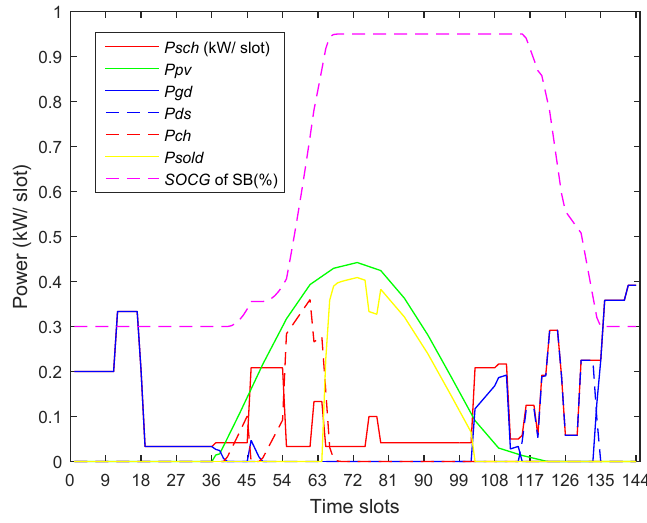
Figure 22. Load profile for maximal reduction in CE using 2S-ToUP (DS) for PDDR-RED-based HEMS.